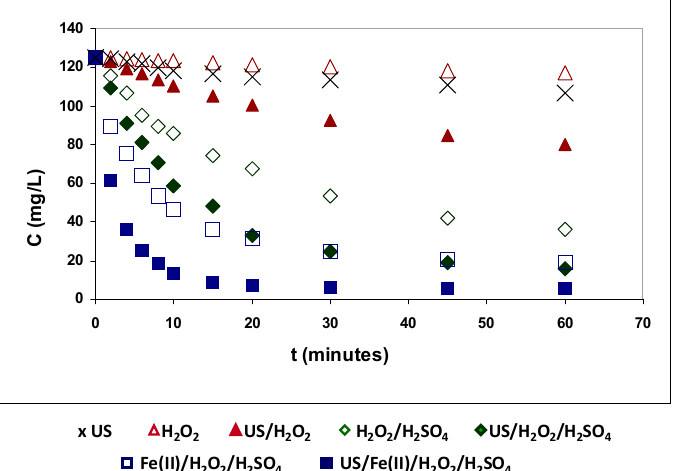
Figure 3. Variation of Acid Brown 83 concentration with time in different degradation methods.